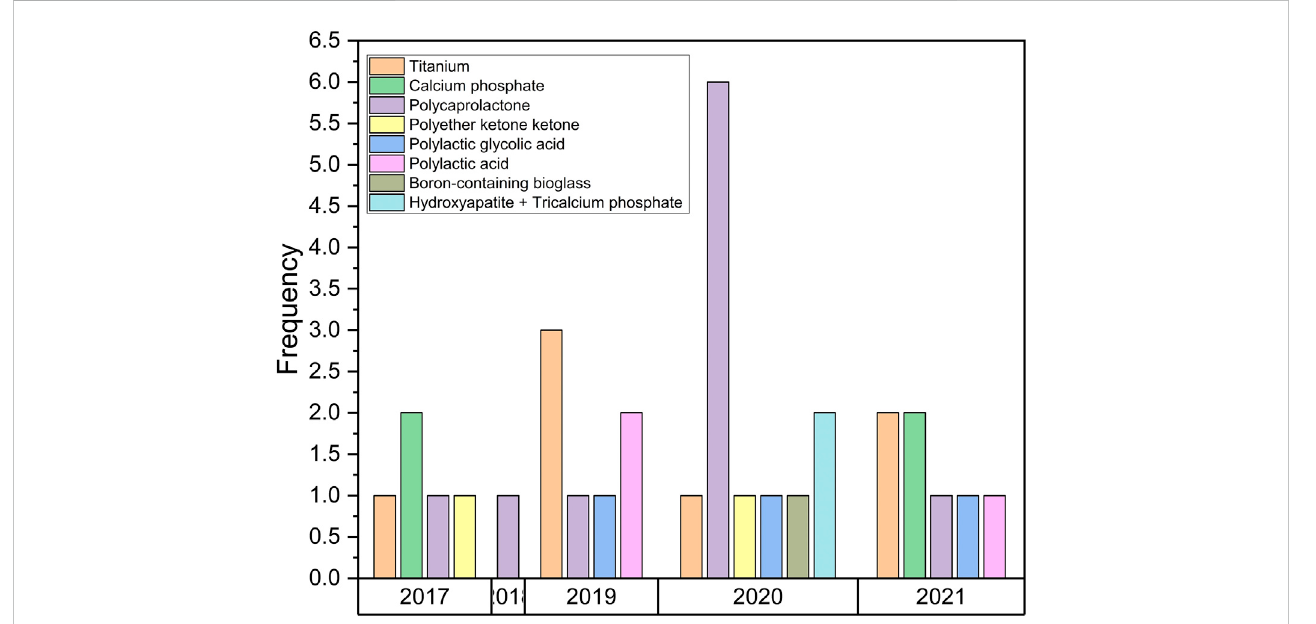
FIGURE 4 Material classi fi cat the microarchitecture of the bone scaffold ion for the mandibular implant.